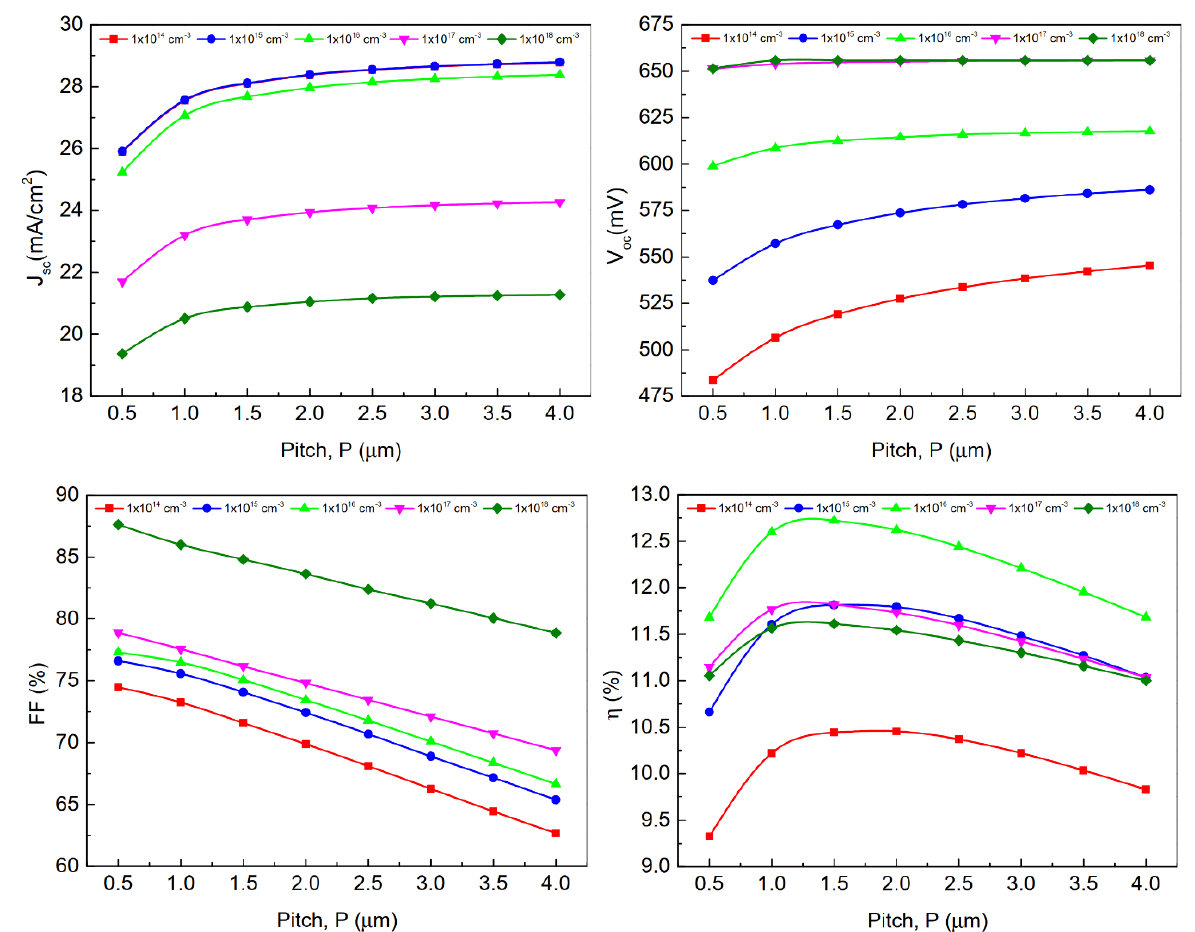
Figure 9. Electric Field comparison for two different donor trap densities (N t ) in ultrathin CIGS devices at equilibrium—0 V Bias.